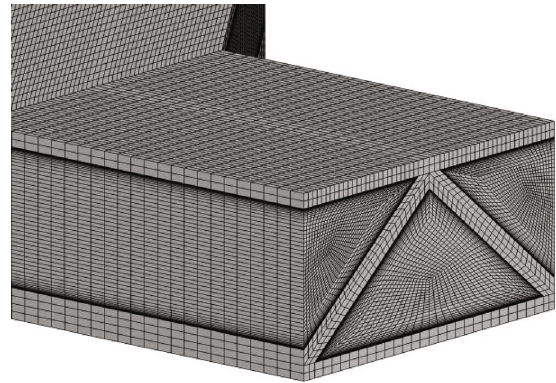
Figure 4: Computational